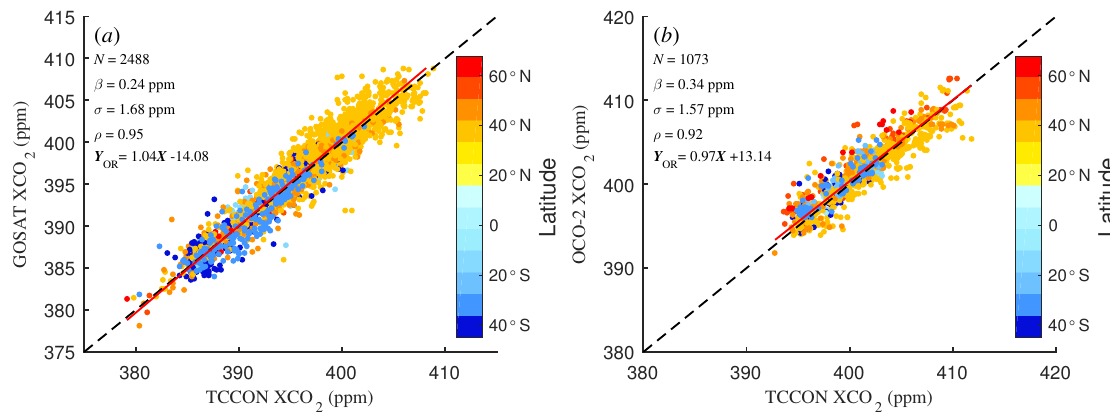
Figure 4. Scatter plot of the collocations of ( a ) TCCON and GOSAT XCO 2 and ( b ) TCCON and OCO-2 XCO 2 using the ± 110 km and ± 30 min coincidence criteria. The colors in both panels represent the latitudes of the TCCON sites. The dotted line represents the one-to-one line, and the red solid line represents the OLR, with the corresponding regression formula shown in the figure. In all figures, N represents the number of matched collocations, β represents the mean bias of the matched data pairs, σ represents the standard deviation, and ρ represents the correlation coefficient of the matched data